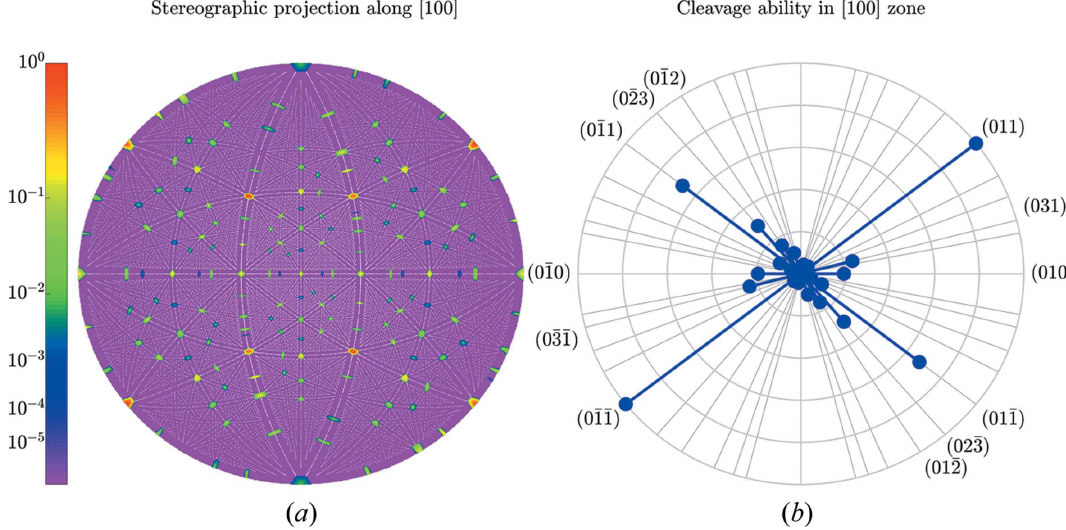
Figure 11 Same as Fig. 5 but for the [100] direction in quartz. The outer circle in ( b ) corresponds to the highest cleavage ability C 011 = 0.714 A˚ .